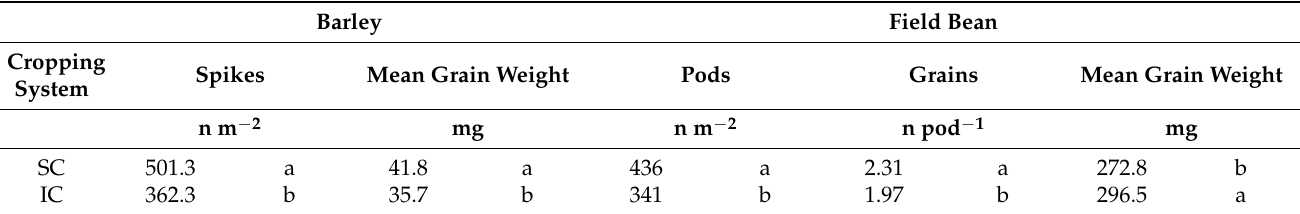
Table 3. Cropping system main effect on number of spikes per unit area and mean grain weight of barley and on pods per unit area, grains per pod, and mean grain weight of field bean.